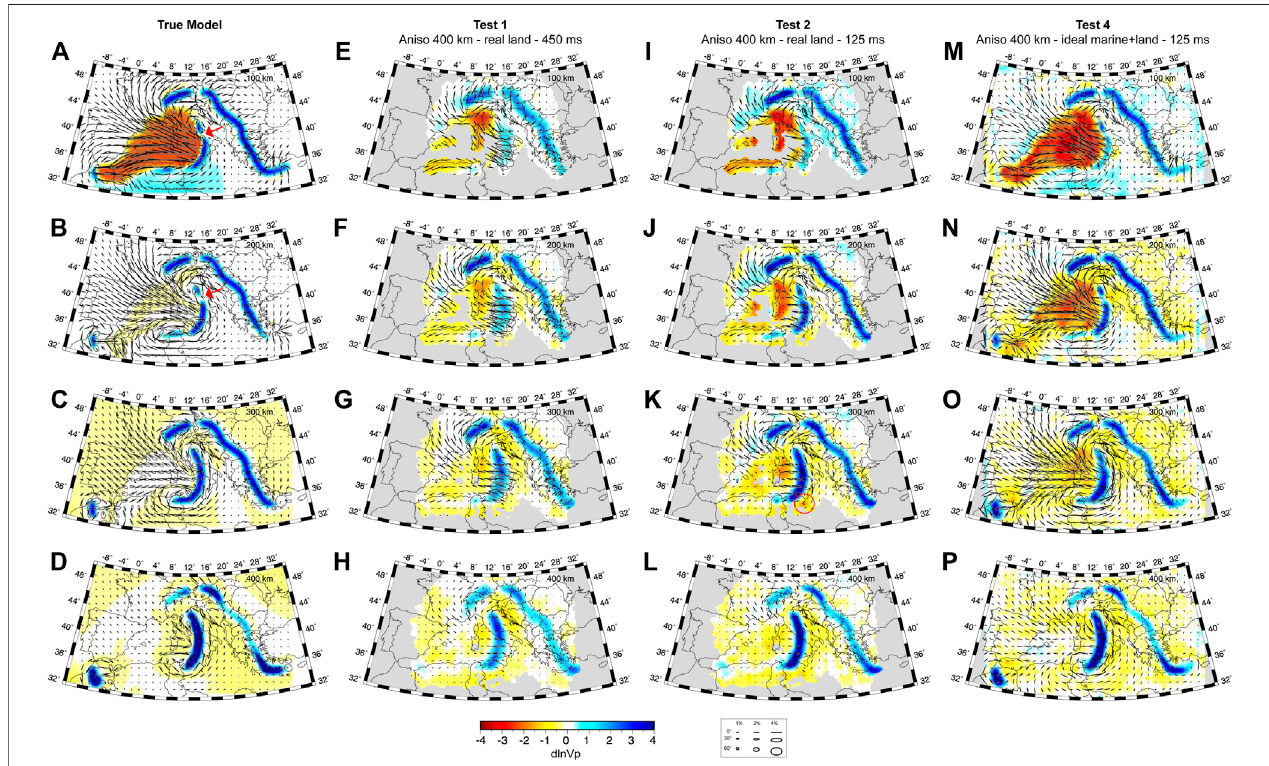
FIGURE 6 | True model and anisotropic tomography results. Depth slices are shown at 100 km, 200 km, 300 km and 400 km depth for the true model (A – D) , the modelresultingfromTest1 (E – H) ,Test2 (I – L) andTest4 (M – P) .Isotropicanomaliesareplottedwithrespecttothereferencevelocitymodel.Weplotanisotropicfabrics as ellipses where the major axis of the ellipse parallels the fast-direction of anisotropy in the view plane and scales with the anisotropic magnitude while the minor axis scales linearly with the symmetry axis dip into the view plane. Thus, fabrics parallel and normal to the view plane plot as lines and circles, respectively; see legend. Areasofpoordatacoveragearemaskedingrey.TheredarrowsinpanelsaandbindicatethepositionoftheslabwindowbelowtheCentralApennines.Theredcirclein panel k indicates a low velocity artefact.